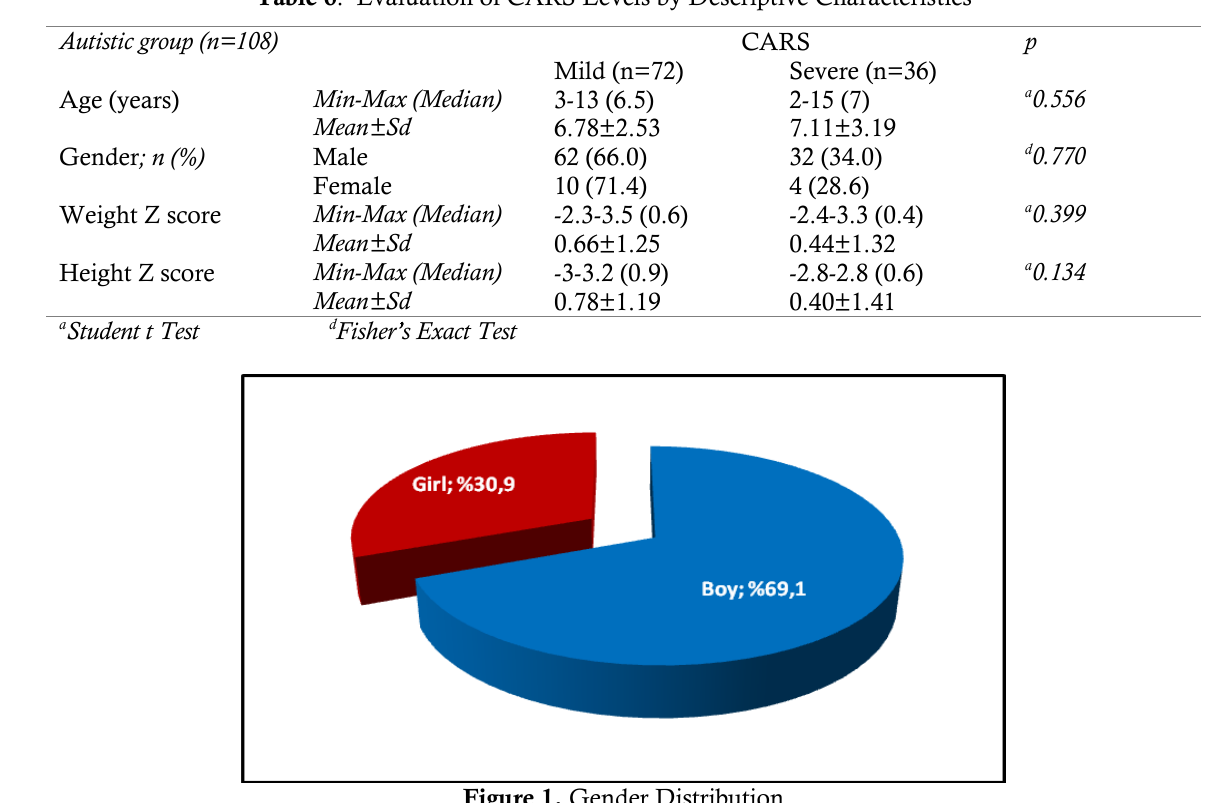
Figure 1. Gender